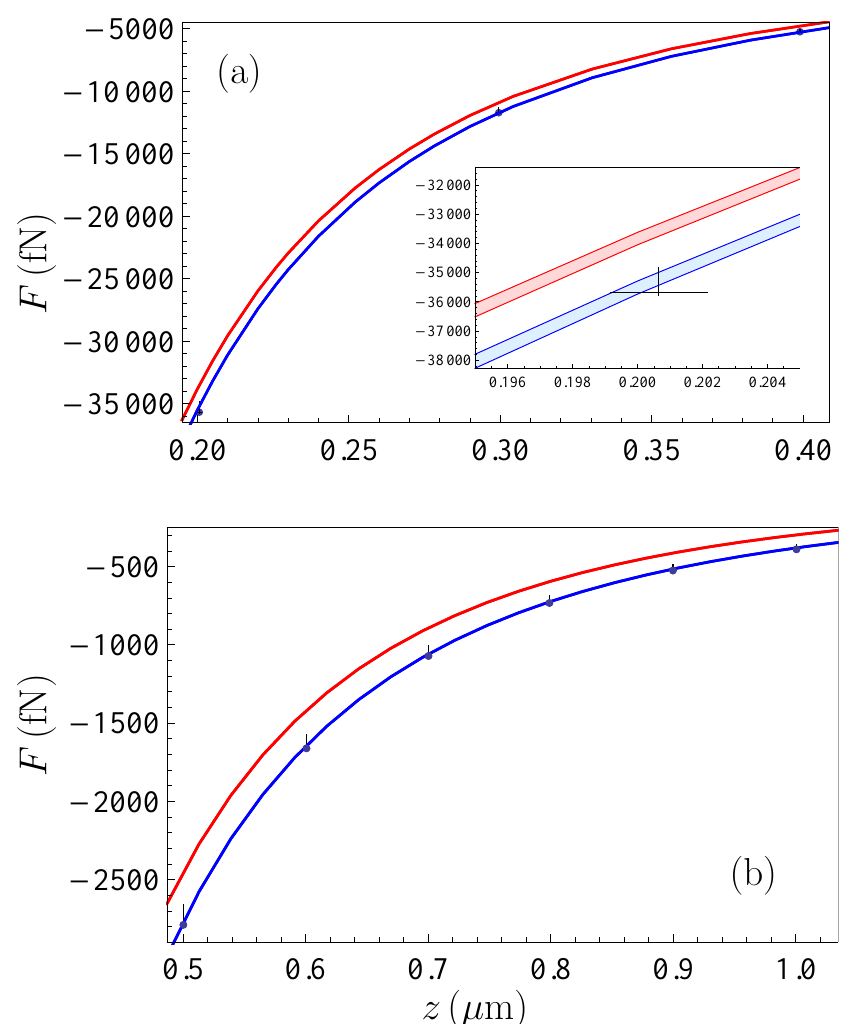
Figure 14. The theoretical Casimir forces computed using extrapolations of the optical data by the Drude and the plasma models are shown as functions of separation by the red and blue lines, respectively, over the region of separations ( a ) from 0.2 to 0.4 µ m and ( b ) from 0.5 to 1.0 µ m. The experimental Casimir forces are indicated as crosses. ( a ) For better visualization the first cross at z 1 = 200.6 nm separation is shown on an enlarged